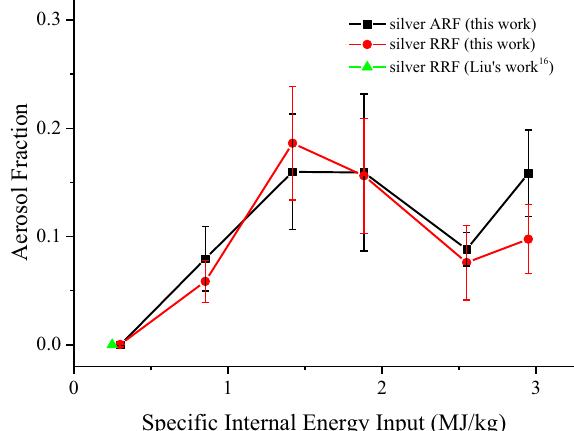
Figure 7. Aerosol release fraction and respirable release fraction of silver aerosol versus specific internal energy input. Error bars were derived from the root mean square of mass concentrations in four TSP or Anderson samplers, when calculating the averages of those concentrations. The RRF of silver aerosol in the former work 16 is also included for